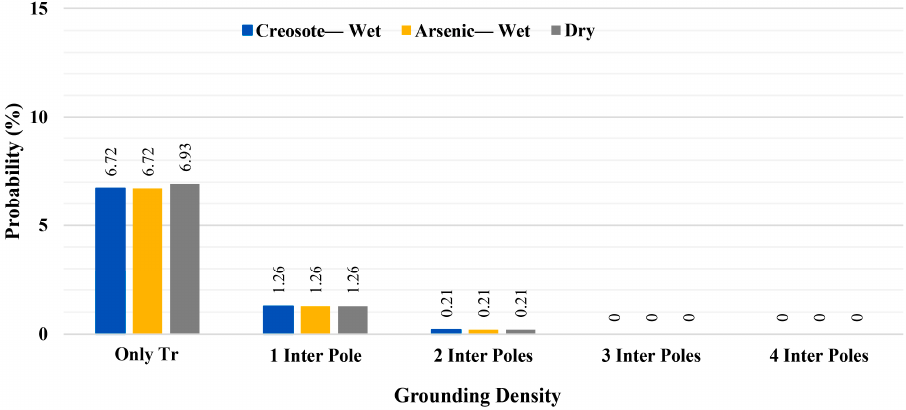
Figure 15. Comparison among the probabilities of transformers experiencing overvoltage stress above 150 kV under different grounding densities, Case 2. 150 kV under di ff erent grounding densities, Case